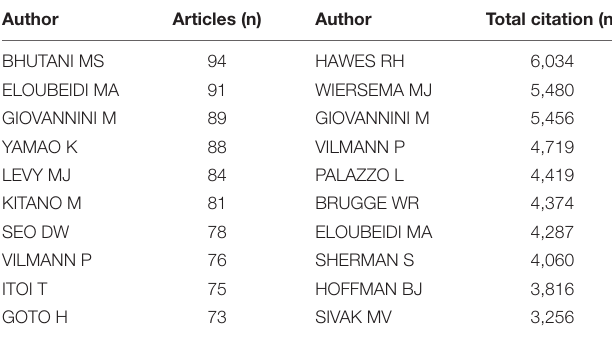
TABLE 1 | The top 10 productive authors and the most-cited authors in the field of